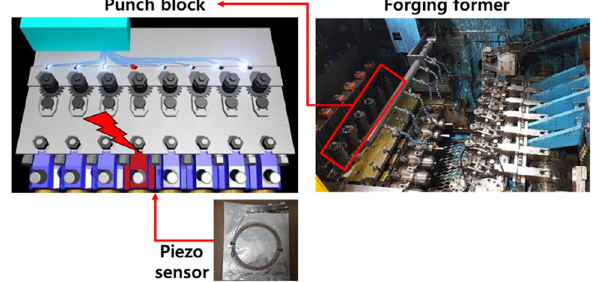
Figure 10. Piezo sensor installation